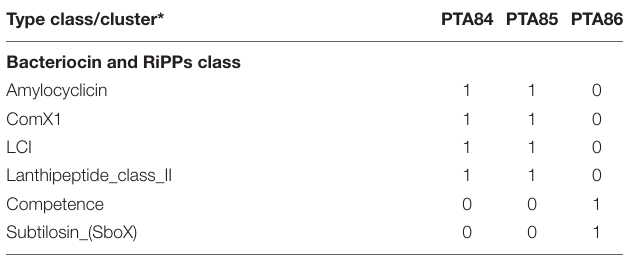
TABLE 2 | Secondary metabolites gene clusters of Ba PTA84, Ba PTA85, and Bs PTA86.